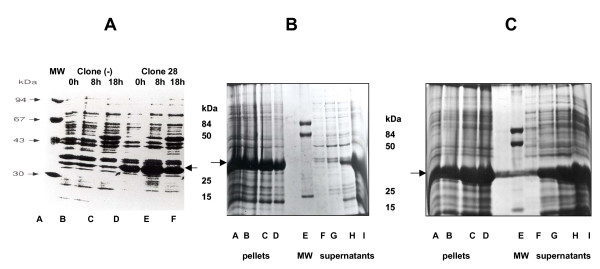
E coli expression and urea extraction of recombinant chimeric protein. Panel A: Coomasie staining of 12.5% SDS-PAGE in reduced conditions of samples from E coli expression. Lanes A, B, C: E coli strain negative control (empty vector), 0, 8 and 18 hours of induction; Lanes D, E, F: E. coli strains containing the expression plasmid pHu (AnTH1) under induction conditions: 0, 8, and 18 hours of induction. Panel B: Urea extraction. Coomasie staining of 12.5% SDS-PAGE under reducing conditions. Lanes A, B, C, and D, pellets and lanes F, G, H, I, supernatants from extraction with 0, 2, 4 and 8 mol/L urea. Panel C: Lanes A, B, C, and D, pellets and lanes F, G, H, I, supernatants from extraction with 0, 5, 6 and 7 mol/L urea. Lanes E in panels B and C indicate the position of MW. The samples contain approximately the same amount of protein. The arrows indicate the position of AnTh1 recombinant protein